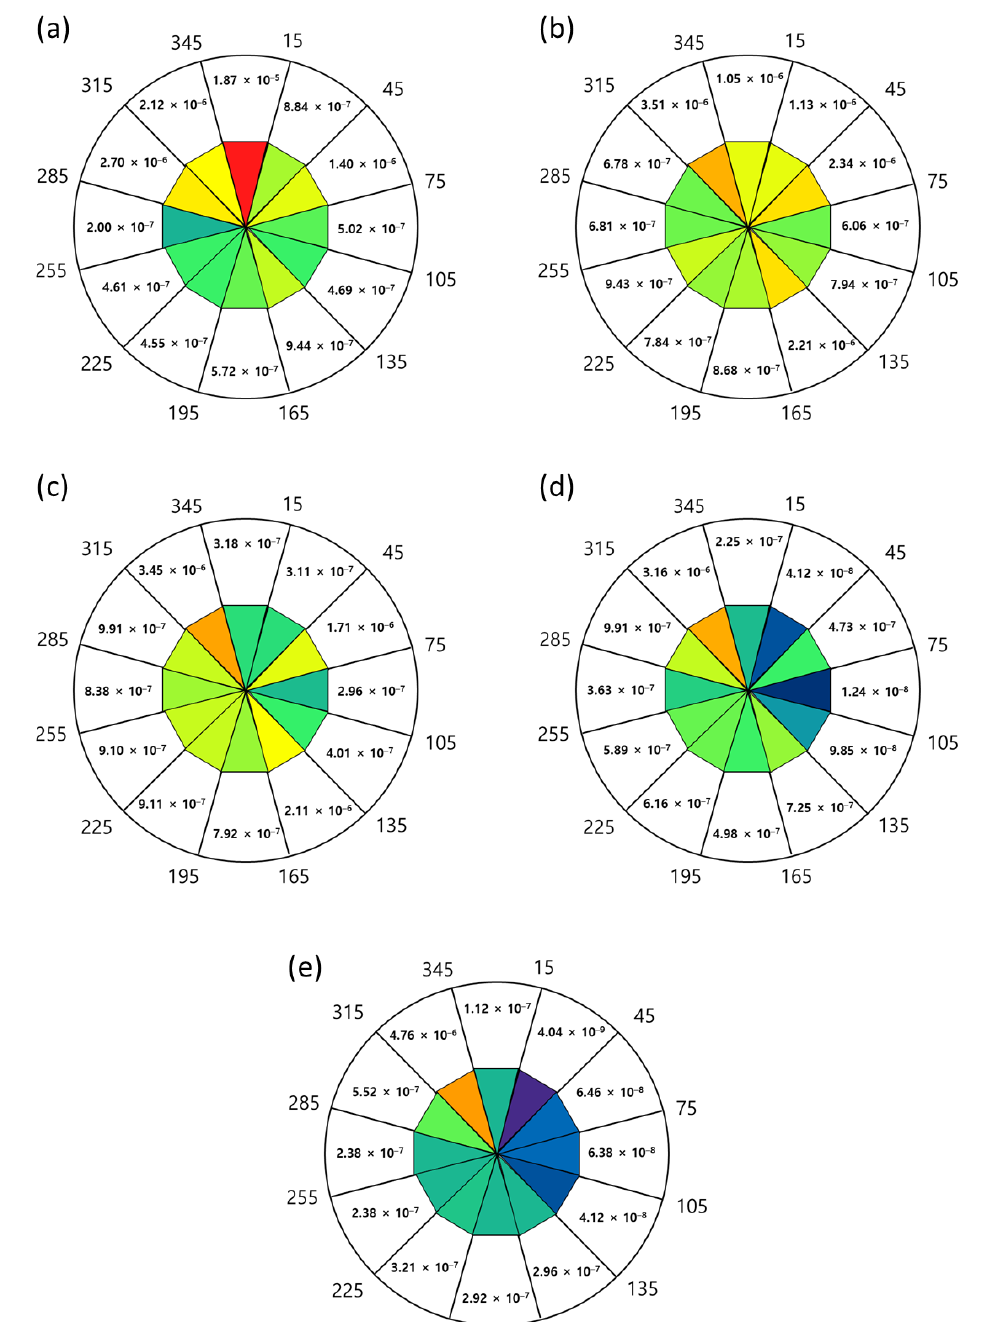
Figure 8. IR of 50% fatality at different wind directions and speeds: ( a ) 0–1 m/s, ( b ) 1–2 m/s, ( c ) 2–3 m/s, ( d ) 3–4 m/s, and ( e ) >4 m/s.